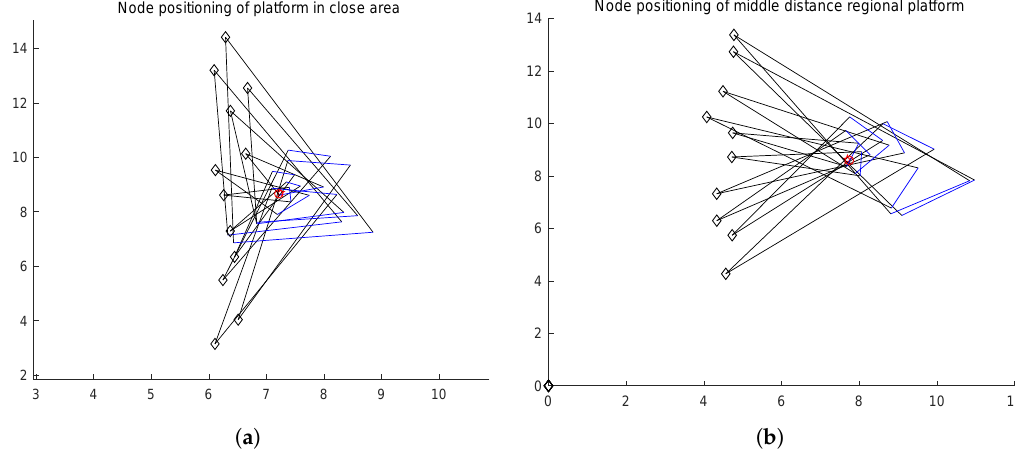
Figure 14. ( a , b ) is the positioning simulation of the platform node when the communication range is near and middle. ( ☆ is the positioning position of the platform to the node, and ◯ is the actual position of the node).